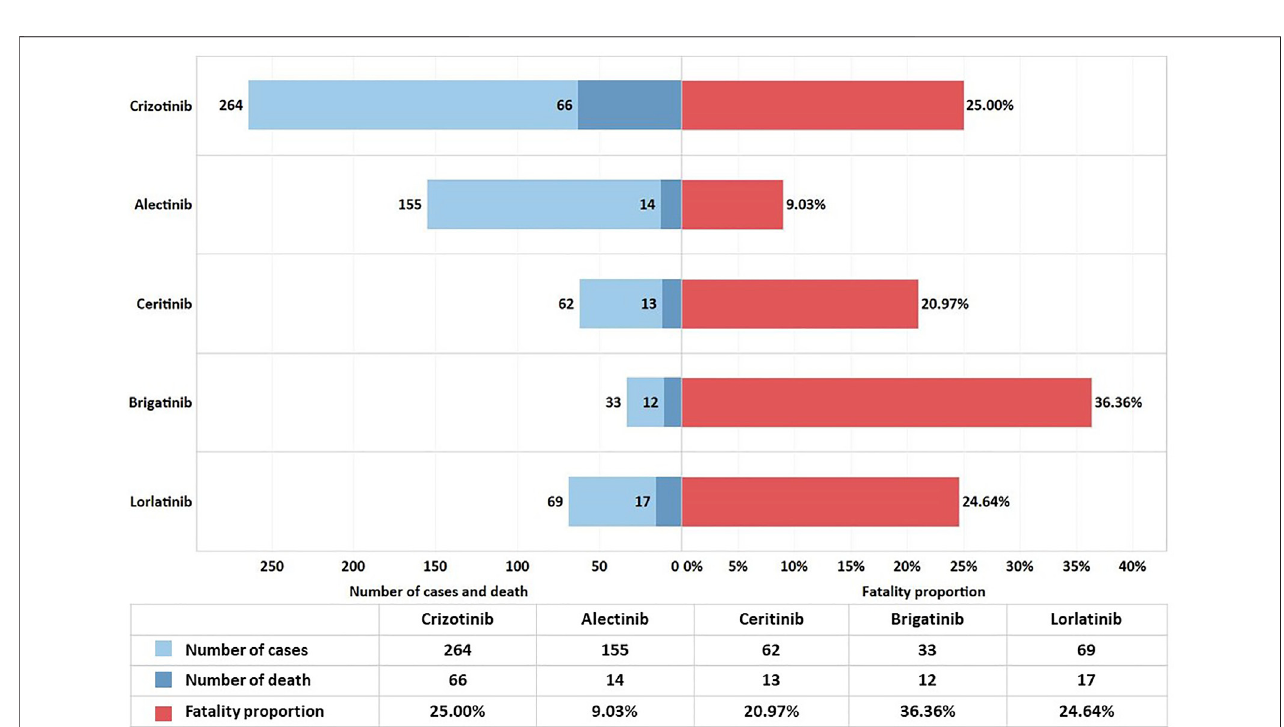
FIGURE 2 | Fatality proportion from ALK-TKI-associated cardiac disorders.